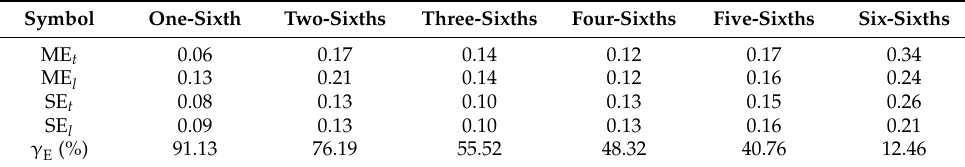
Table 2. The means and the standard deviations of EP t and EP l and the proportion γ E .